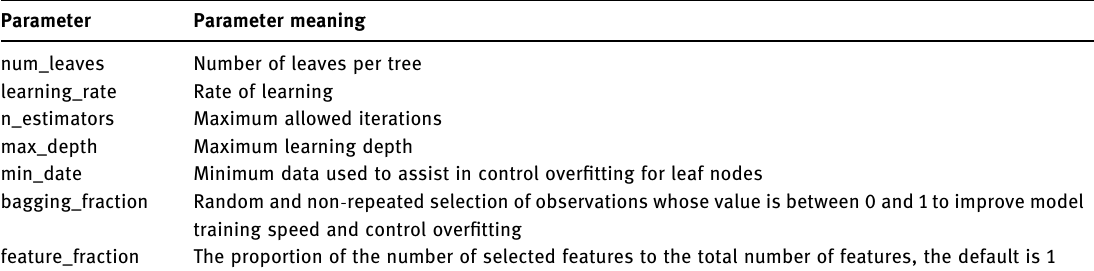
Table 1: Signi fi cance of the main parameters of